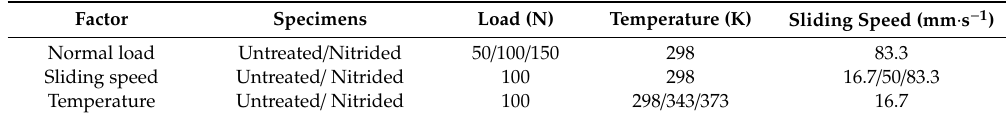
Figure 2. Schematic diagram of ball-on-disc wear test. Table 2. The experimental conditions of friction